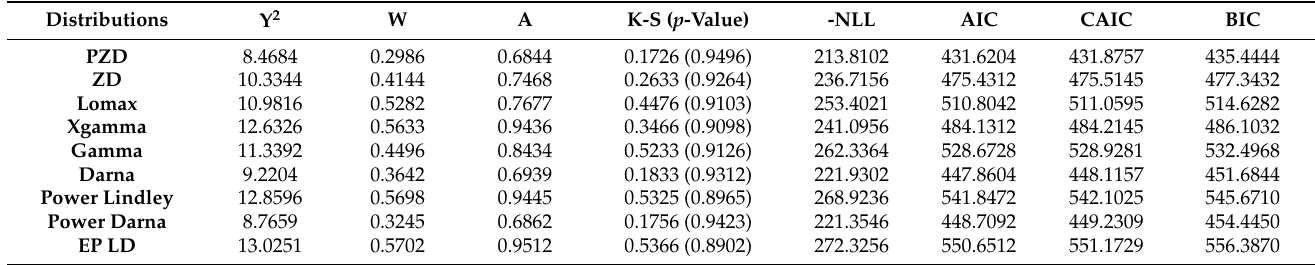
Table 6. Values of criteria statistics for model selection based on failure times data.